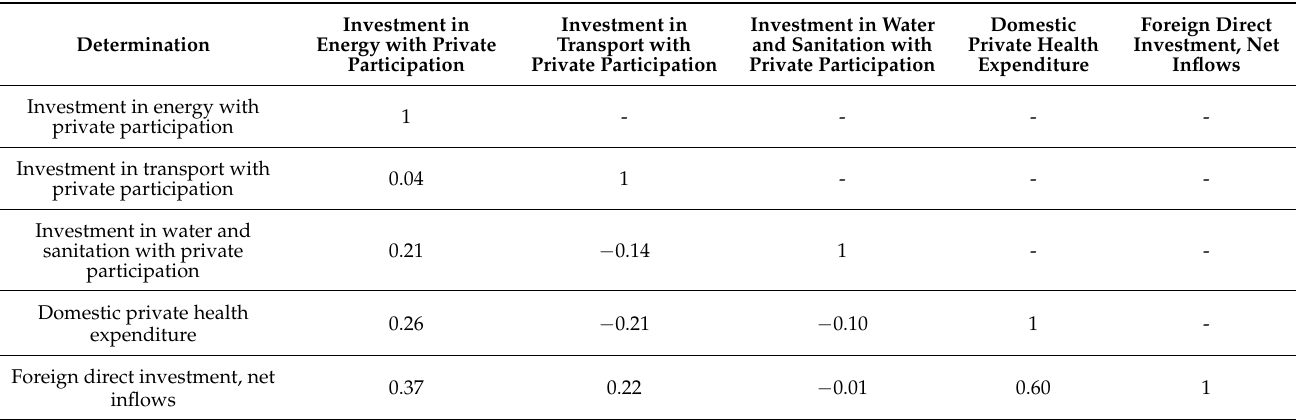
Table 3. Assessment of endogeneity of the factor